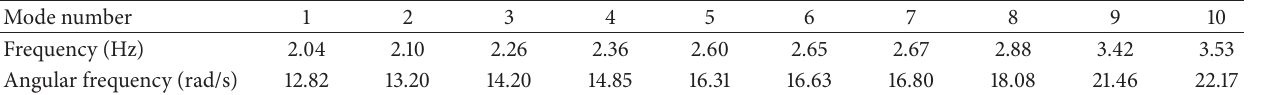
Table 3: Results of free vibration